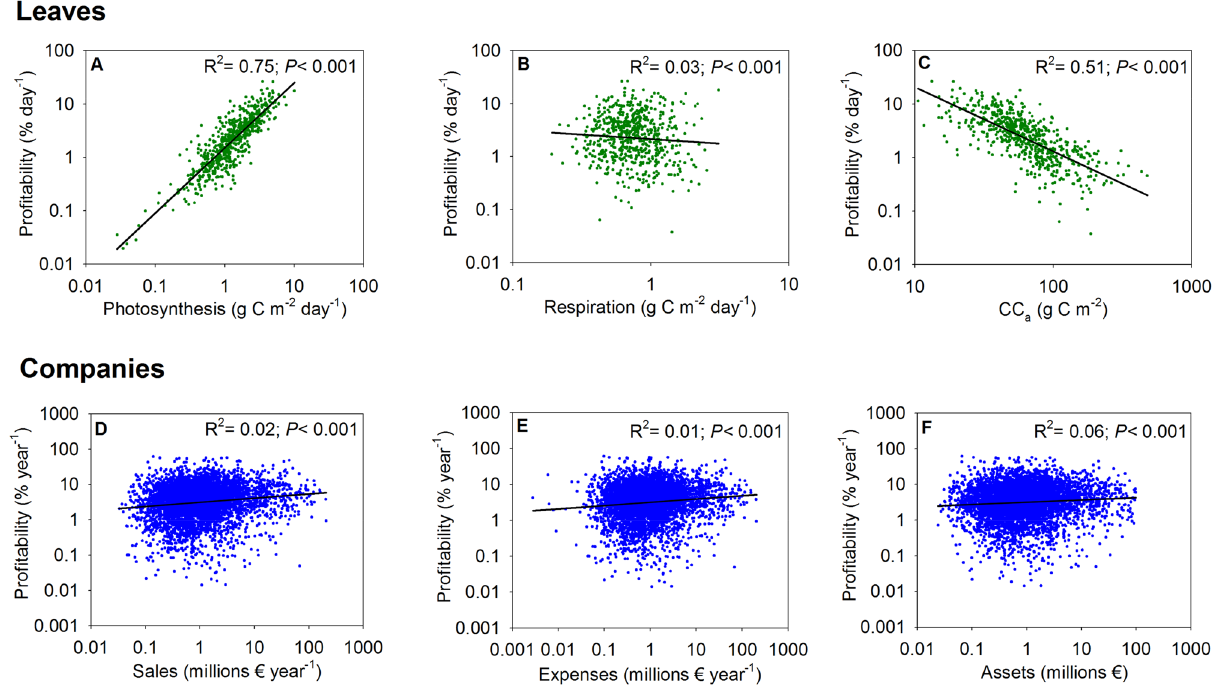
Figure 3. Factors related to leaf and company profitability. For leaves, relationships of profitability with ( A ) photosynthesis gains; ( B ) respiration expenses and ( C )construction cost per leaf area (CC a ). For companies, relationships of profitability with ( D ) sales; ( E ) expenses and ( F )